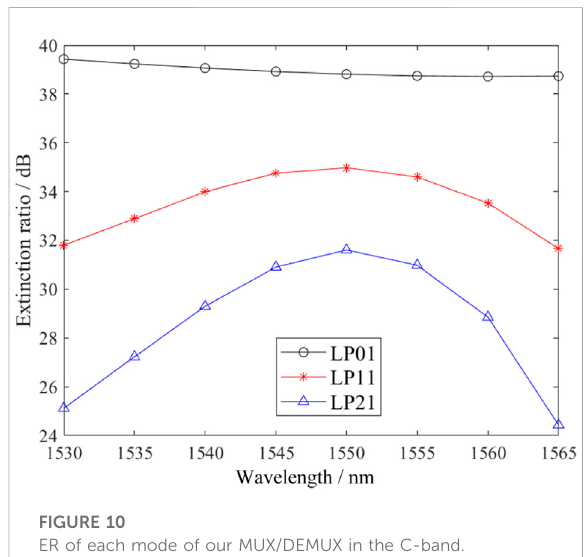
FIGURE 10 ER of each mode of our MUX/DEMUX in the